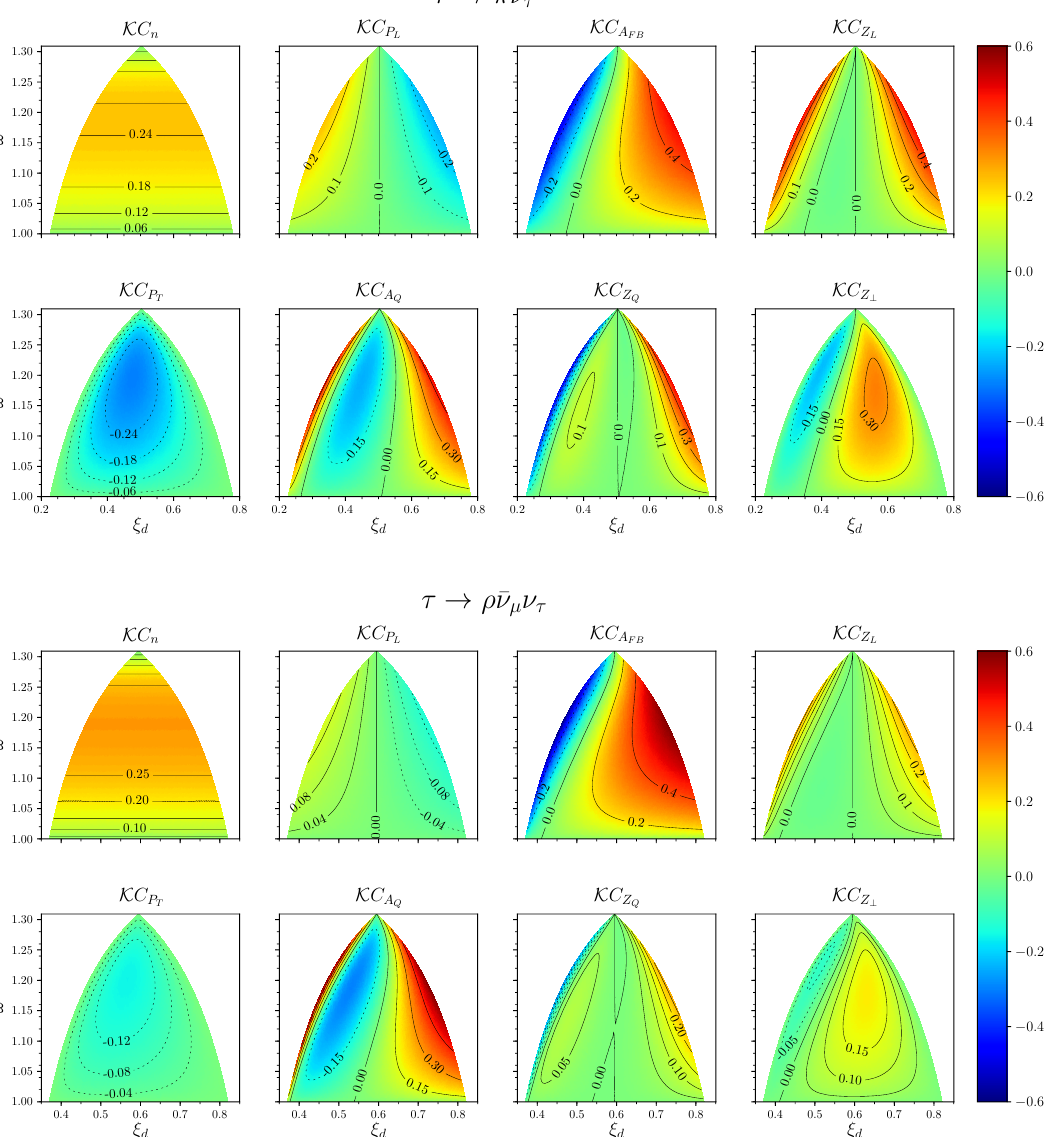
Figure 3 . Two dimensional p ω, ξ d q dependence of the coefficients (multiplied by the kinematical ? factor K p ω q (cid:16) ω 2 (cid:1) 1 p 1 (cid:1) m 2 { q 2 q 2 ) introduced in eq. (3.47) for the π and ρ hadronic tau-decay τ modes. Each of the coefficients affects one of the observables introduced in eq. (3.46), within the corresponding F d p ω, ξ d q partial wave contribution to the d 3 Γ d {p dωdξ d d cos θ d q differential decay 0 , 1 , 2 width of eq. (3.42) (see text at the end of section 3.4 for further details). The used p ω, ξ ranges d q correspond to those available for the Λ Λ ¯ ν sequential decays. Note that dotted b (cid:209) c τ p πν τ , ρν τ q τ contour lines correspond to negative values, while solid ones stand for positive (or zero)